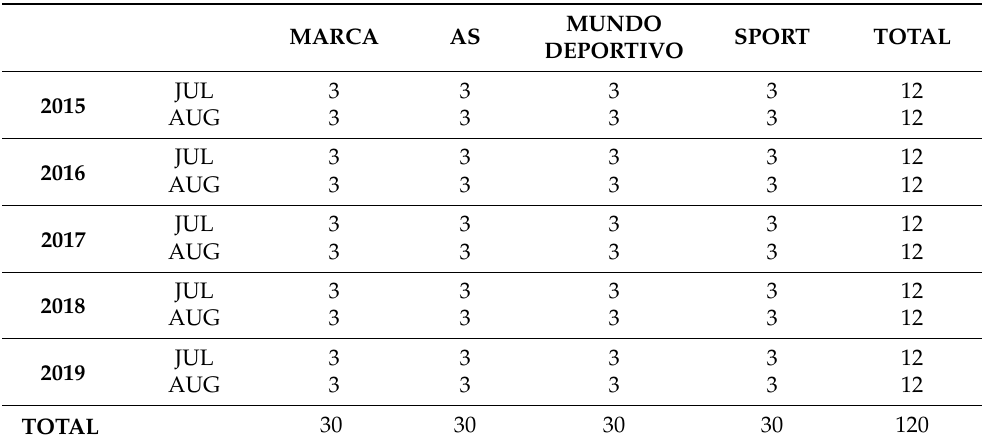
Table 2. Sample. Compiled by